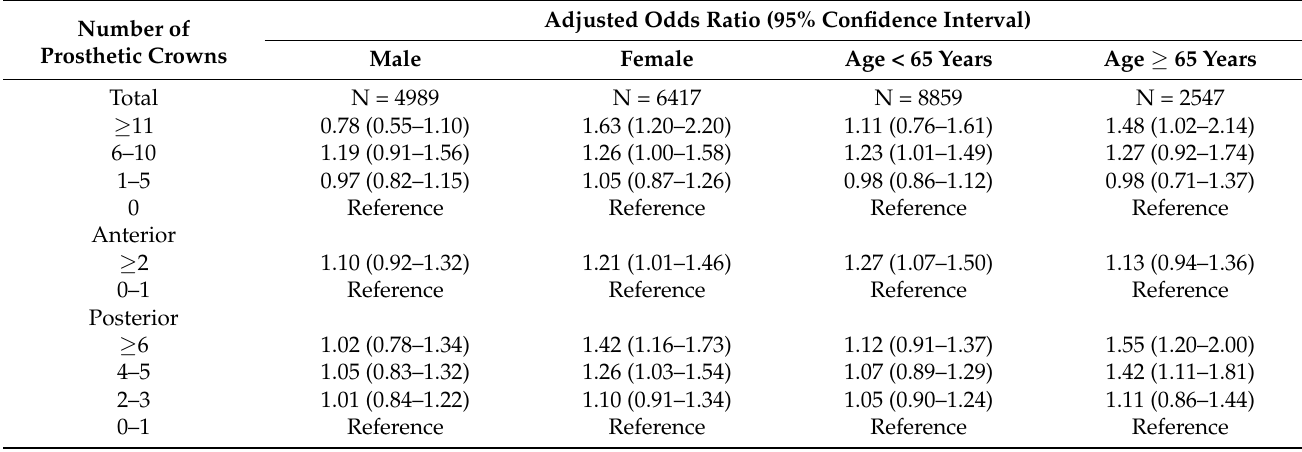
Table 3. Multivariable association between the number of prosthetic crowns and periodontitis by sex and age stratification. Number